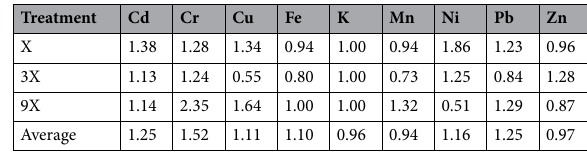
Table 6. Enrichment factors (EF) of shoots of barley.